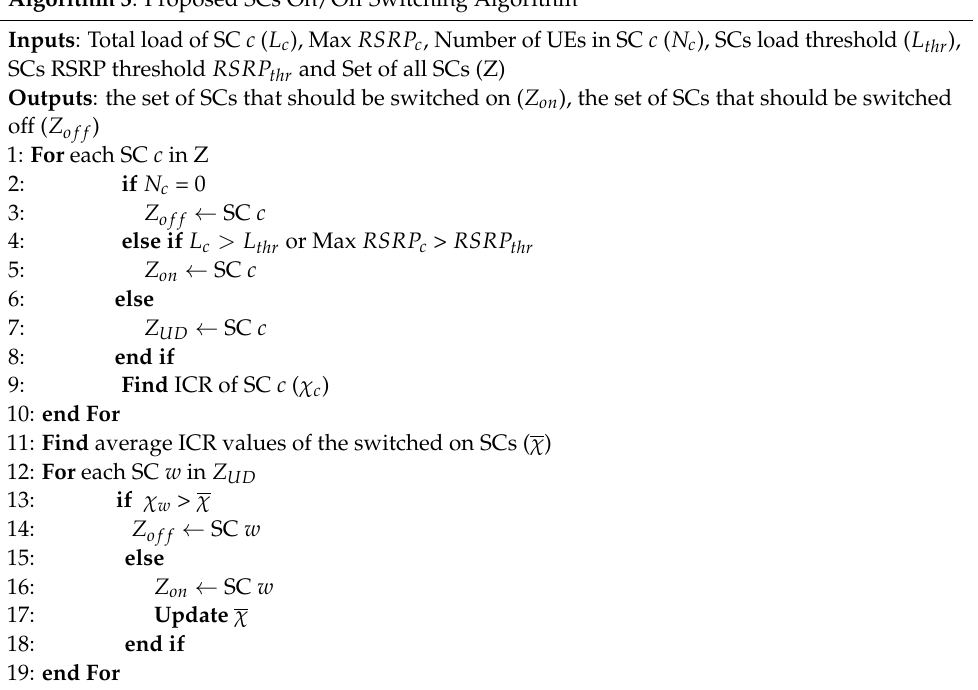
Algorithm 3 : Proposed SCs On/Off Switching